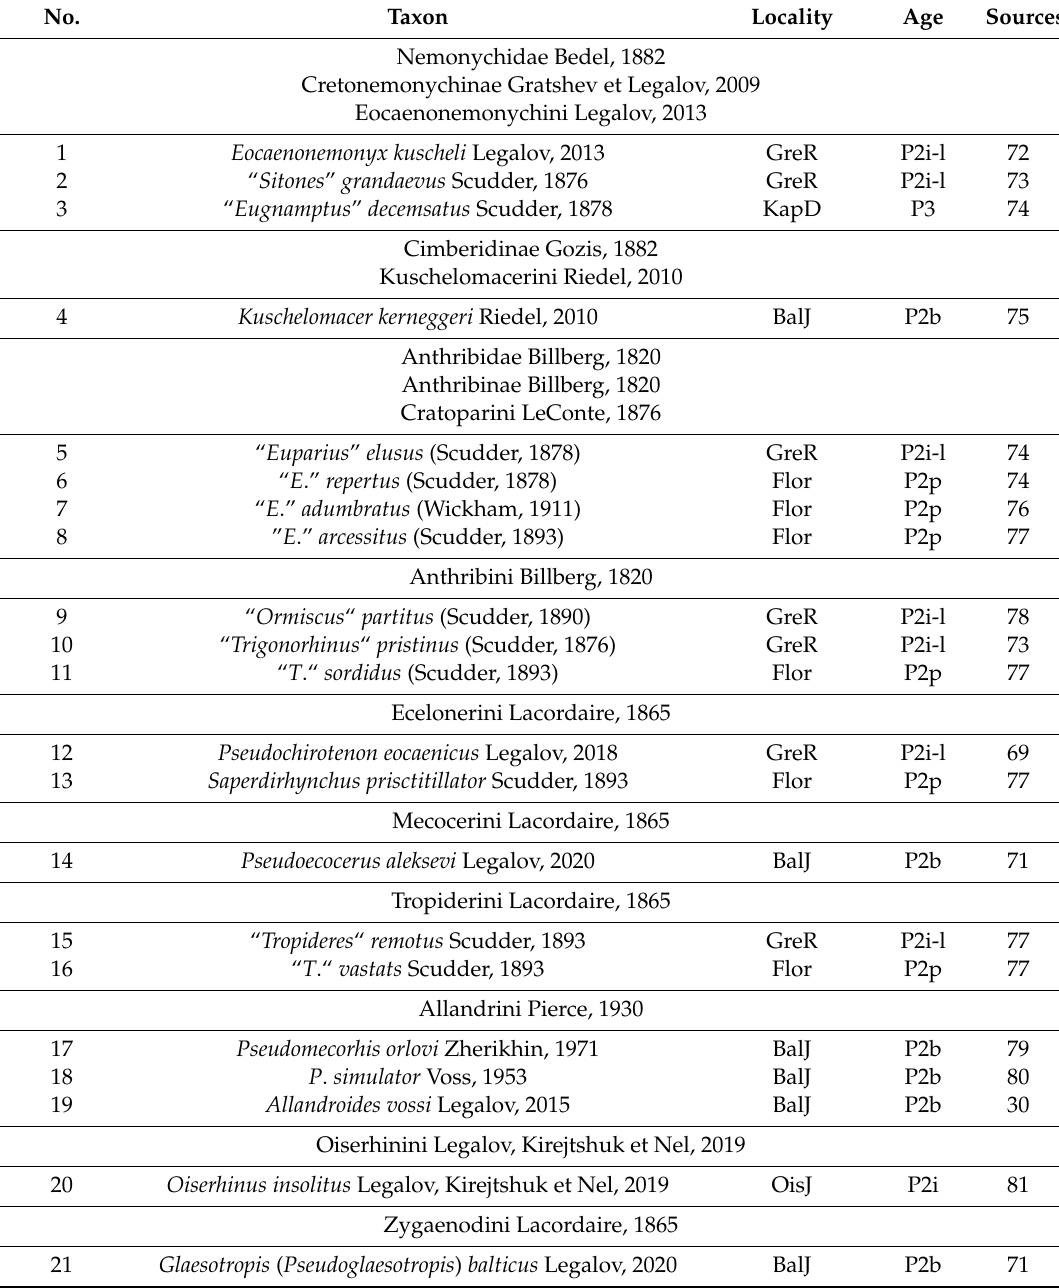
Table 2. List of species of Curculionoidea from Paleogene [8,29,30,47,50,67,69–175]. No. Taxon Locality